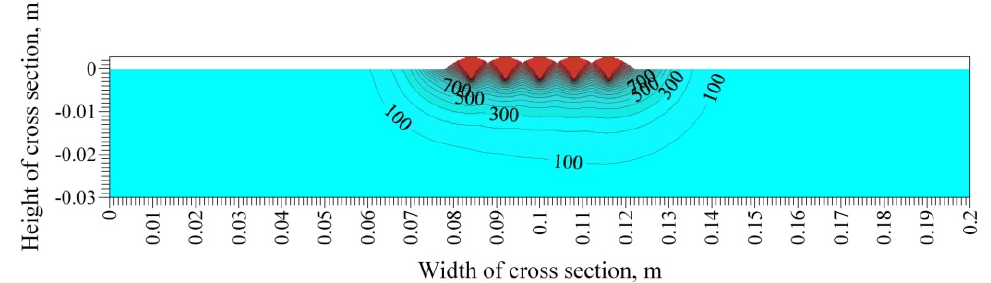
Figure 13. Temperature distribution (°C) on the surface of an element ( z = 0) during the application of third weld at time t = 83 s (position of electrode y = 0.1 m, x = 0.25 m).